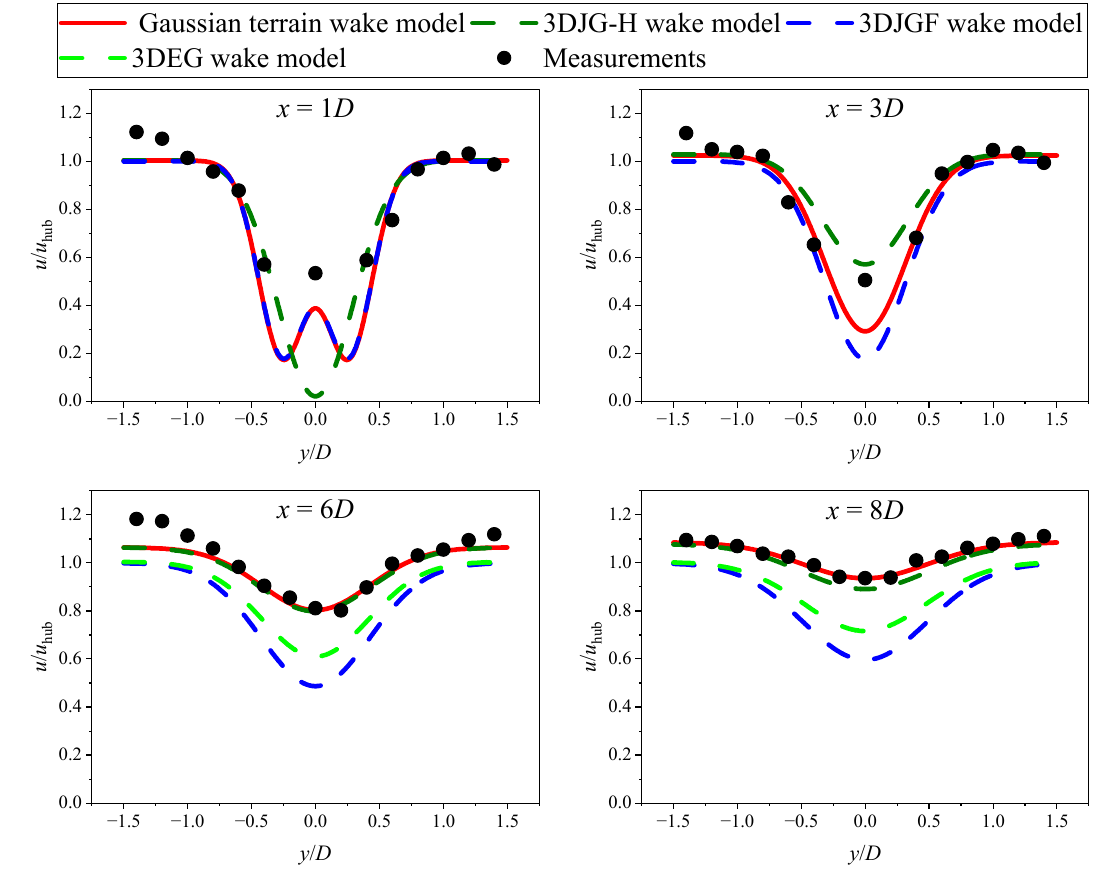
Figure 8. Comparison results of horizontal profiles at four downstream locations.